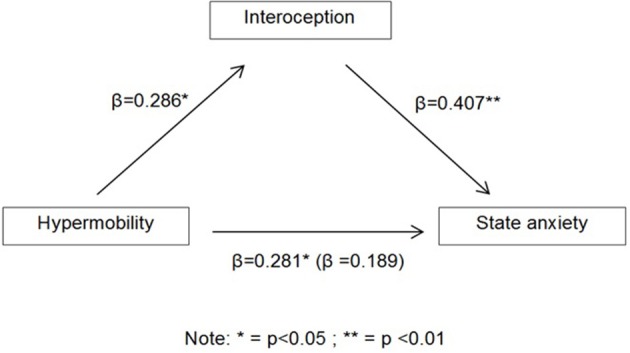
Schematic showing the regression coefficients, with the coefficients (β) for the effect of hypermobility on state anxiety with the latter (when entering interoception into the model) in parentheses.